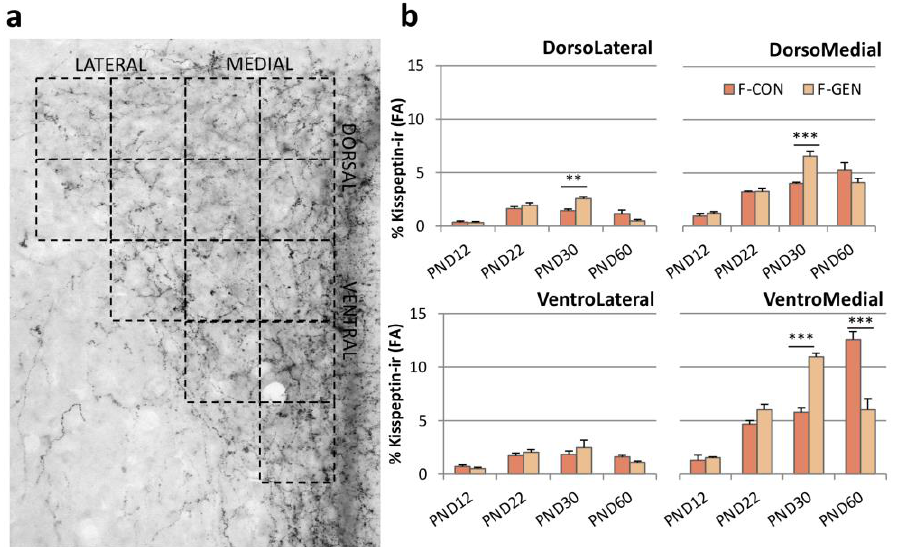
Figure 7. ( a ) Photomicrograph of kisspeptin immunostaining in the PVN of adult control females, showing the subdivision of the PVN in fourteen quadrants to identify the four parts of the nucleus (DM, dorso-medial; DL, dorsolateral; VM, ventro-medial; VL, ventro-lateral). ( b ) Variations of the FA covered by kisspeptin immunoreactive fibers in the different parts of the PVN (DM, DL, VM, VL) in control (F-CON) and treated (F-GEN) female CD1 mice at different ages of sacrifice (PND12, PND22, PND30, and PND60). Scale bar = 50 µm. ** p ≤ 0.01; *** p ≤ 0.001 (Bonferroni test).